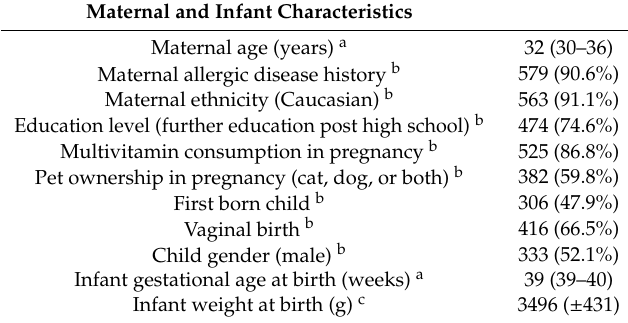
Table 1. Study population ( n = 639) maternal and infant demographical characteristics.